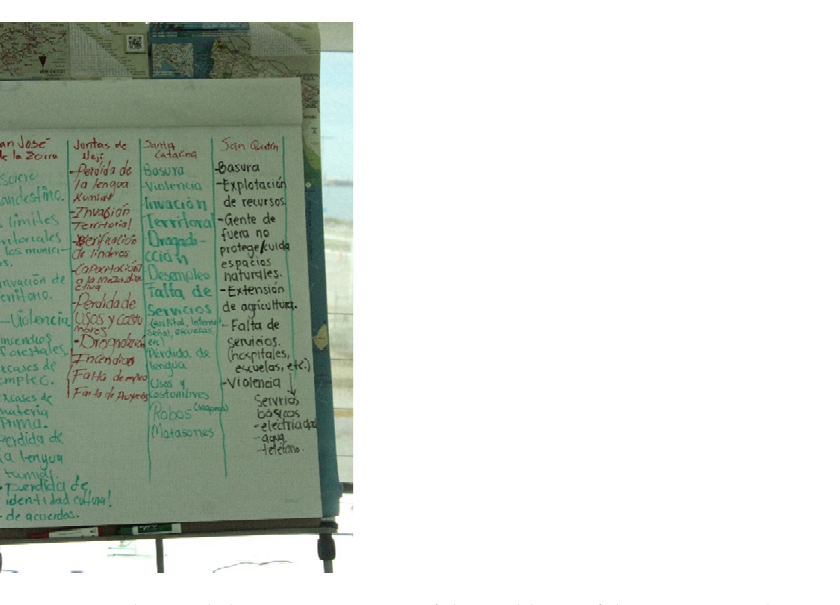
Figure 3. Nunaliit workshop in the city of Ensenada. Pa Ipai families during learning how to use the Nunaliit software. Credits: Martín Cuitzeo Domínguez Núñez.